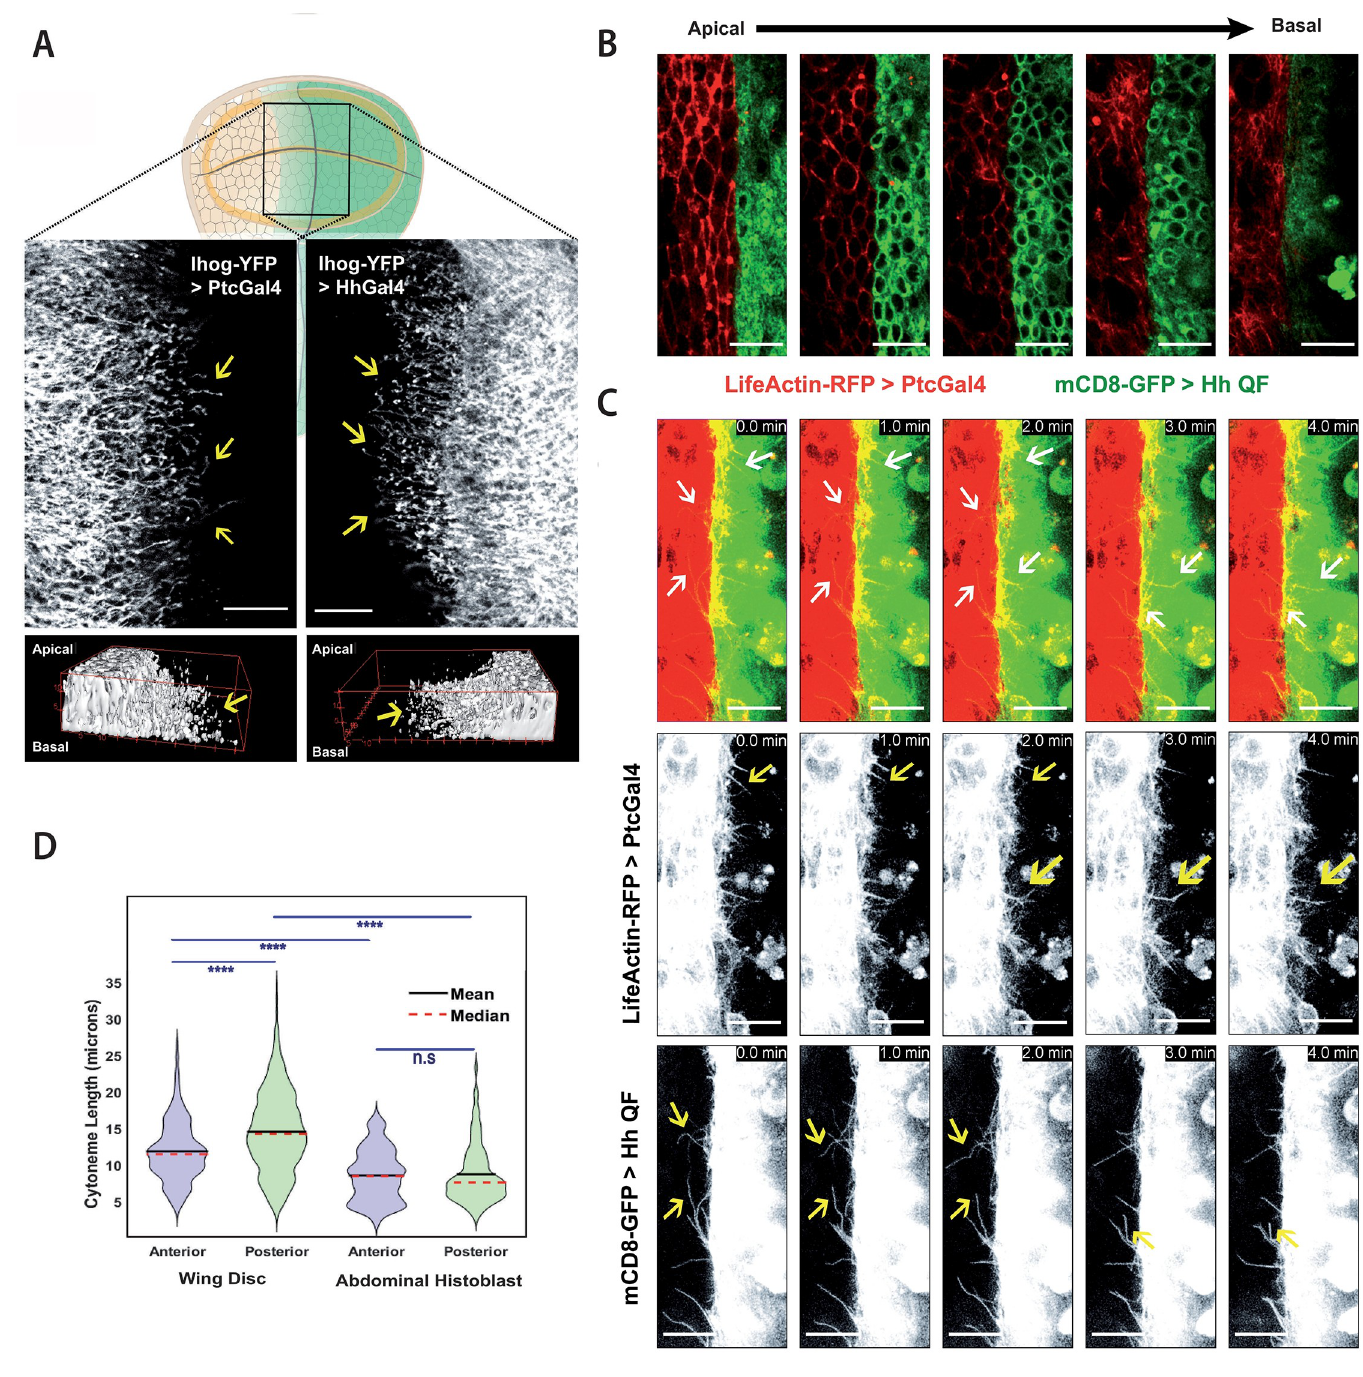
Fig 3. Experimental cytoneme characterization in Drosophila tissues. (A) Wing imaginal disc cytonemes protruding from A (top left) and from P (top right) compartment cells marked with Ihog-RFP. Bottom panels show 3D reconstructions of a confocal Z-stack taken at the basal side of the tissue showing cytonemes protruding and from A (bottom left) and P (bottom right) compartment cells. (B) A confocal Z-stack taken from the apical to basal side of the abdominal histoblast epithelium with the A compartment marked with life-actin-RFP (red) and the P compartment marked with CD8GFP (green). (C) In vivo temporal sequence of abdominal histoblast cytonemes taken at one-minute intervals. Top image sequences show both A and P compartment labelled cytonemes (A in red, P in green), middle image sequences show a single channel of A compartment cytonemes, and bottom image sequences show the single channel of P compartment cytonemes. (D) Statistical violin plots of cytoneme length distribution in the A (blue) and the P (green) compartments in wing disc (left) and abdominal histoblast nest (right). Scale bars: 15 μ m.